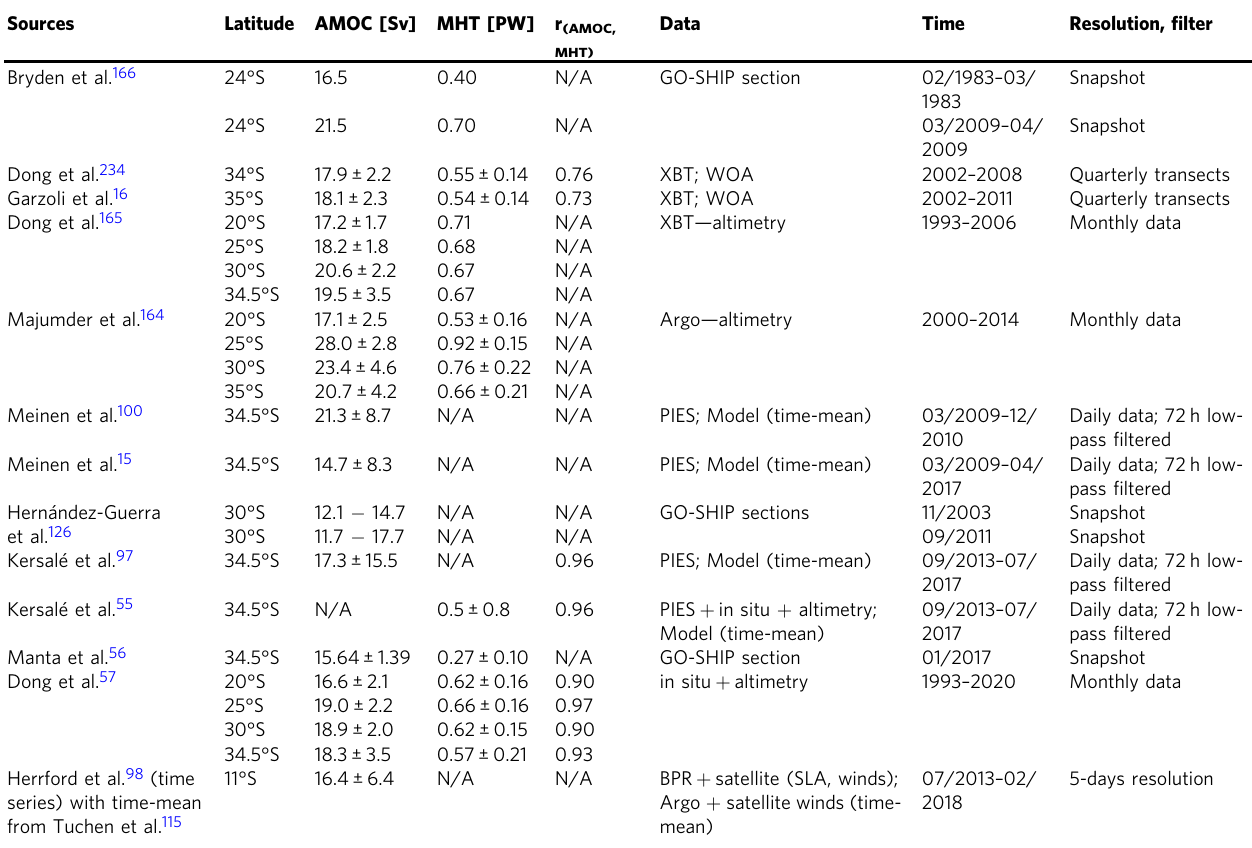
The reference citation, data, and time period used are also indicated (month information is given if the record does not span a full year). Positive transport values indicate northward transport. The correlation (r AMOC,MHT ) values between AMOC and MHT time series are included when